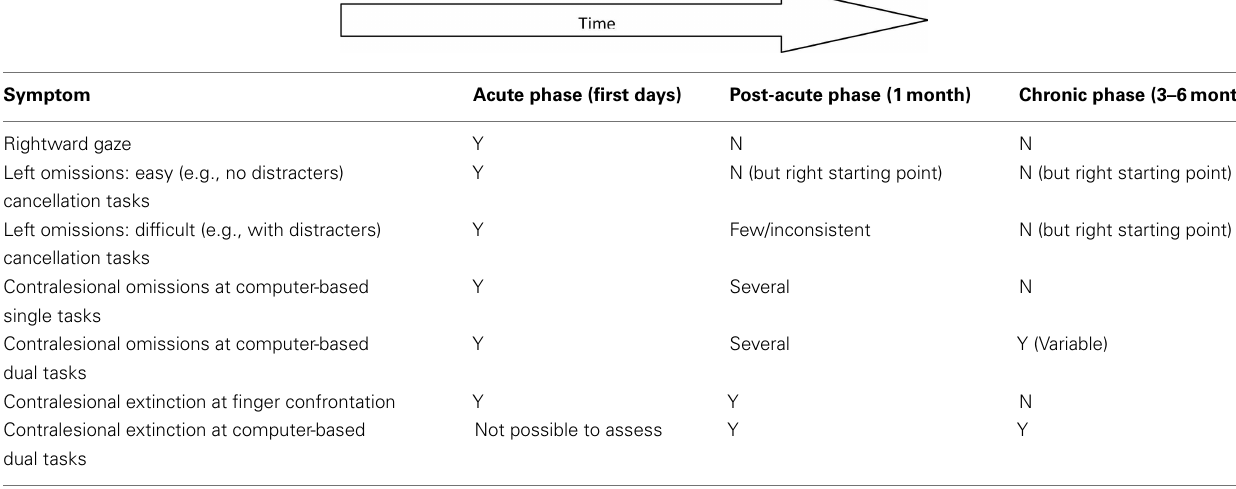
Table 1 |A simple graphical representation of hierarchy of spatial impairments presented by a “typical” patient following a stroke of the middle right cerebral artery in the acute, post-acute, and chronic phases,